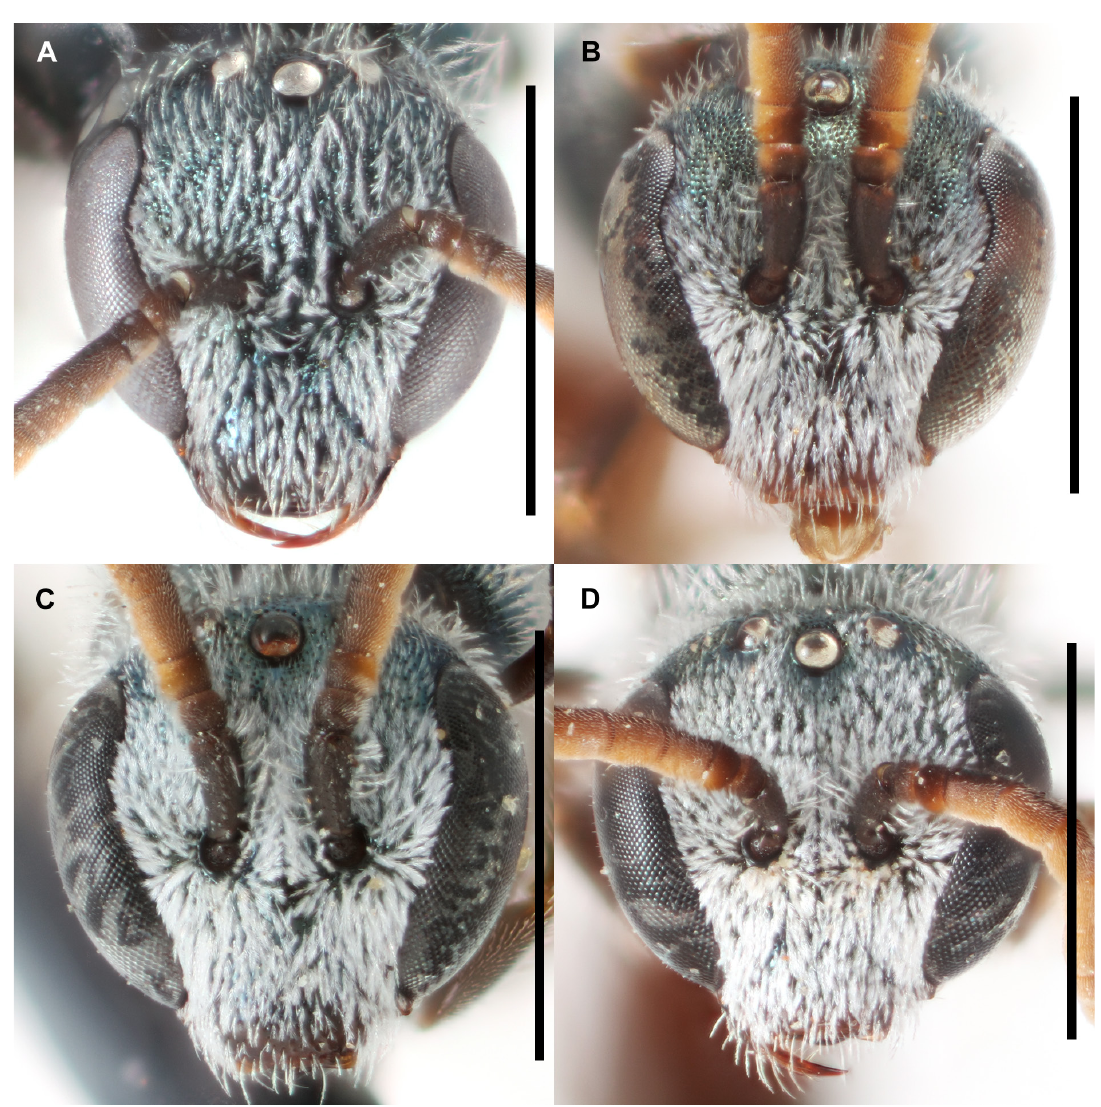
Fig. 102. Face. A . Lasioglossum holzenthali sp. nov., ♂, with dense tomentum on lower paraocular areas and sparser tomentum between. B . L. ellisiae (Sandhouse, 1924), ♂, with dense tomentum below eye emargination. C . L. deludens sp. nov., ♂, with dense tomentum slightly above eye